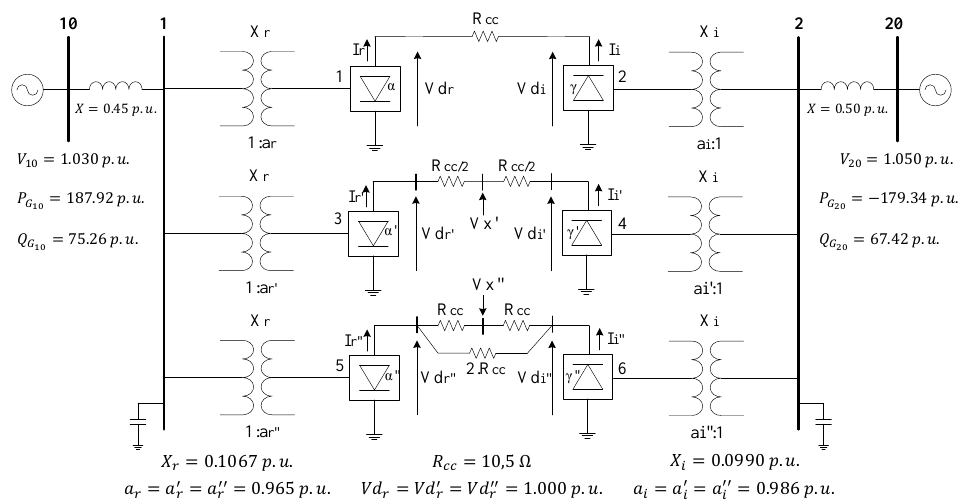
Figure 4. Four-bus test system including three HVDC with different DC